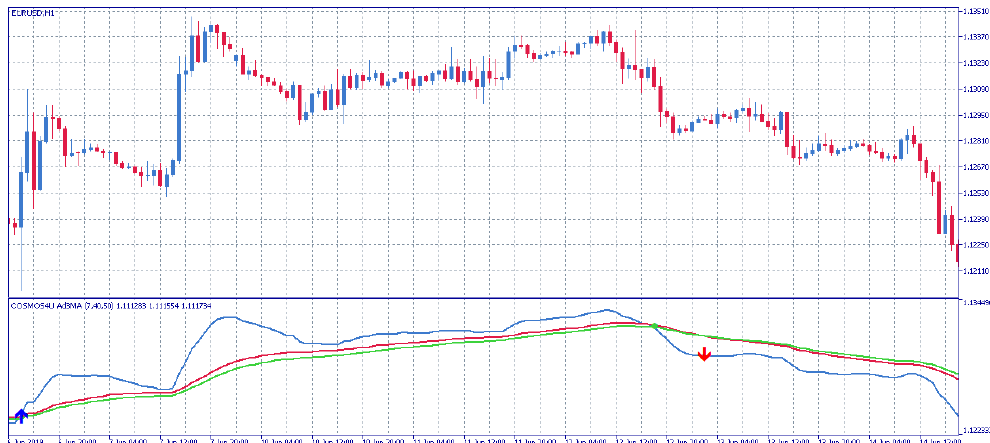
Figure A3. EUR/USD chart with signals from the Ad3MA